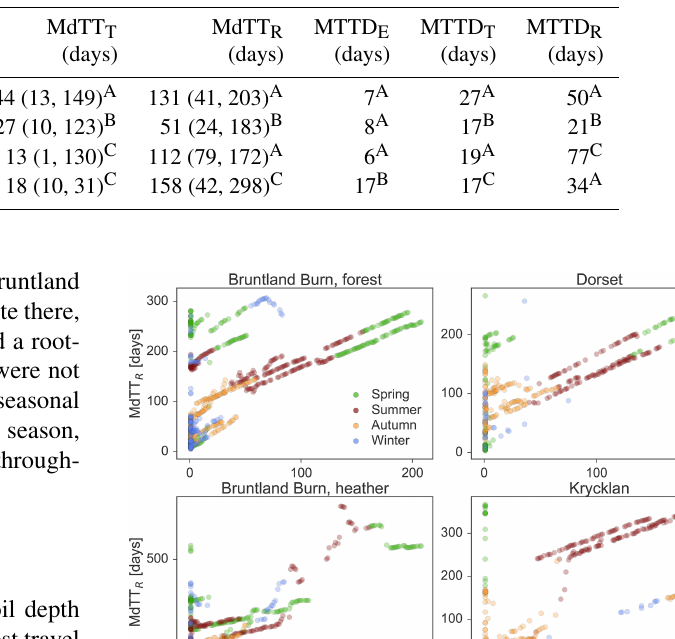
Table 2. Summary of median travel time (MdTT, shown in Fig. 2) and master travel time distribution (MTTD) characteristics of the four study sites: median of MdTT (25th percentile, 75th percentile) in the evaporation flux (MdTT E ) , transpiration flux (MdTT T ) , recharge flux (MTT R ) , median of the MTTD of the evaporation flux (MTTD E ) , transpiration flux (MTTD T ) , recharge flux (MTTD R ) . Letters as superscript indicate significant differences in each column. Sites with the same letter are not significantly different regarding the MdTT or MTTD of the considered flux.